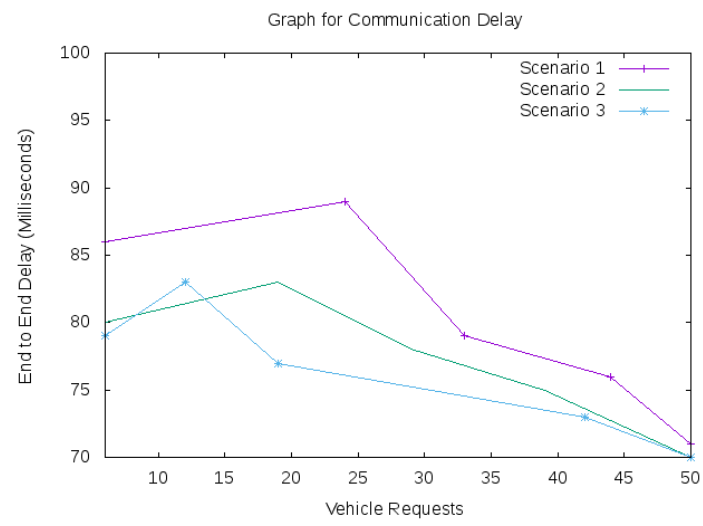
Figure 5. Graph for communication delay.